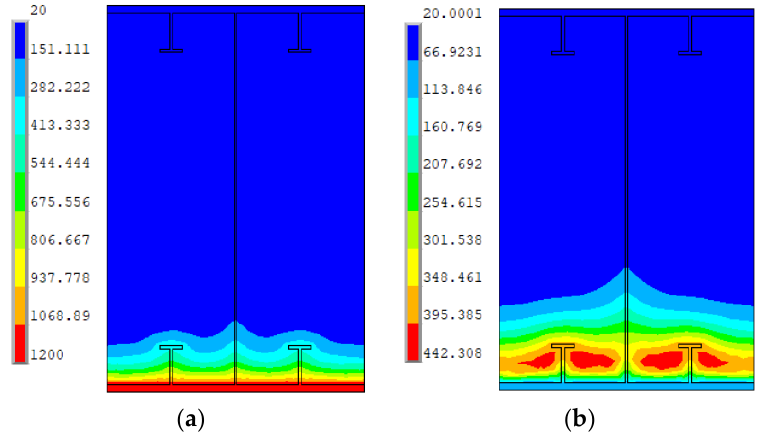
Figure 21. Forward contour plot of the member. ( a ) At 7200 s; ( b ) At 13,500 s.